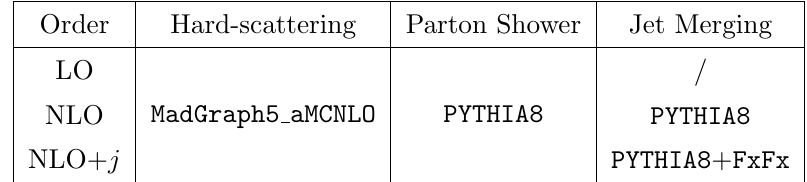
Table 1 . Summary of the tools used for the event generations at each order in the QCD perturbative